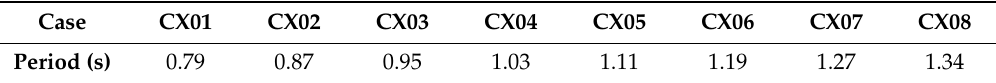
Table 3. Wave periods of the regular sea waves considered in the study.